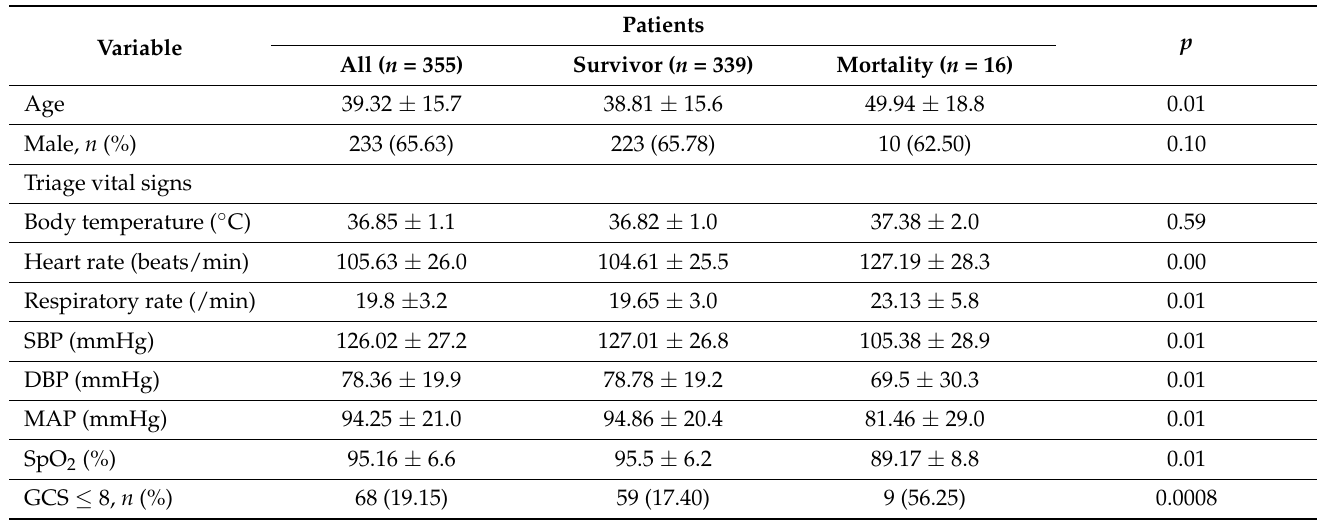
Table 2. Characteristics of the illicit drug users on arrival at the ED of survivors and mortality